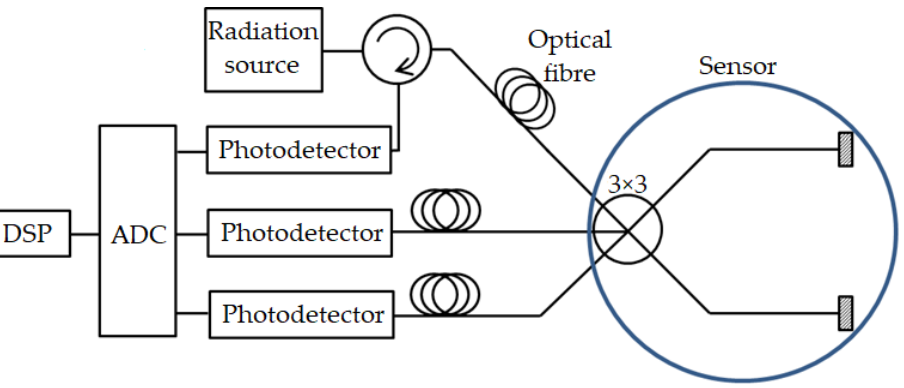
Figure 2. Connection of the sensor system with the fiber-optic